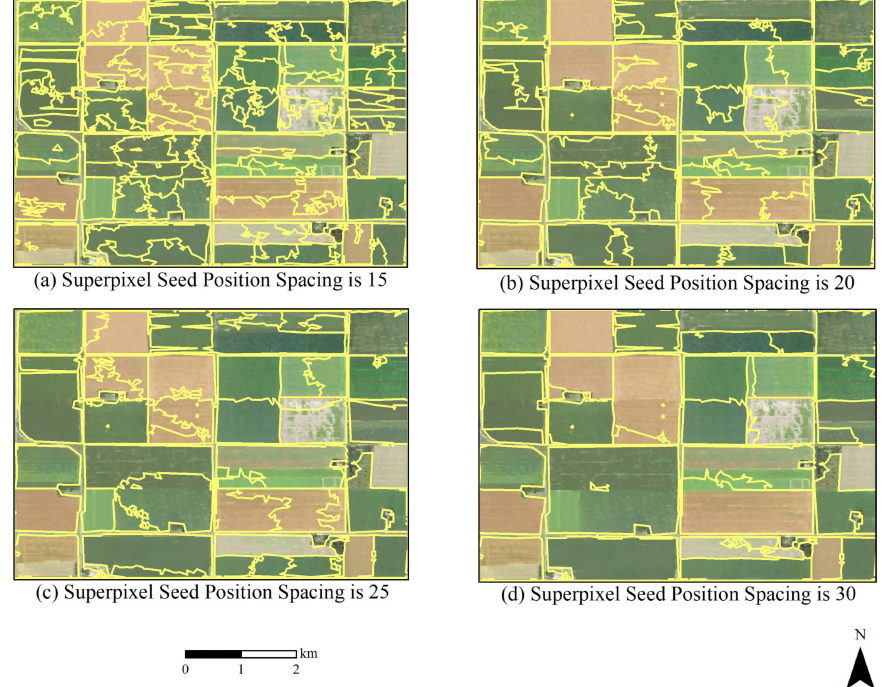
Figure 6. SNIC segmentation results using seed spacing parameters of 15 ( a ), 20 ( b ), 25 ( c ), and 30 ( d ).